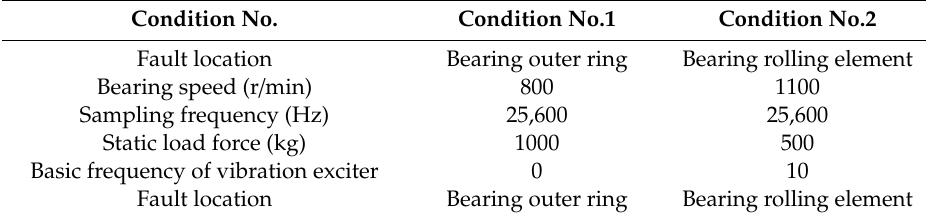
Table 5. Working condition table of axle box bearing testbed.